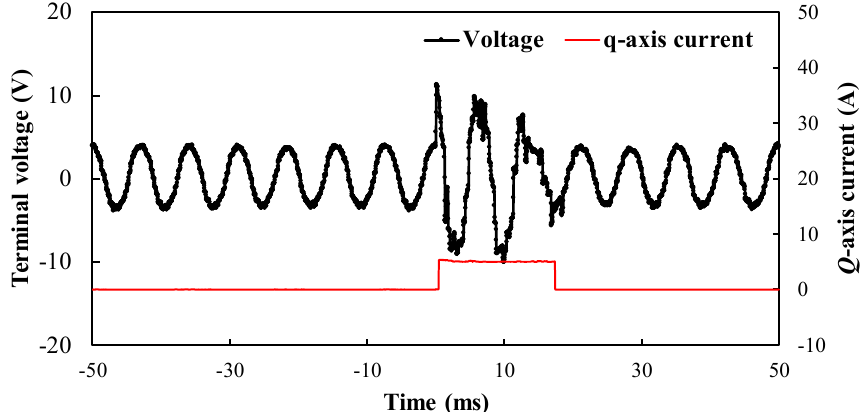
Figure 16. Measured terminal voltage transient response to a current pulse of I q excitation of 5A, 400 r/min. (The magnetizing current and the d -axis armature current values are both set as zero).